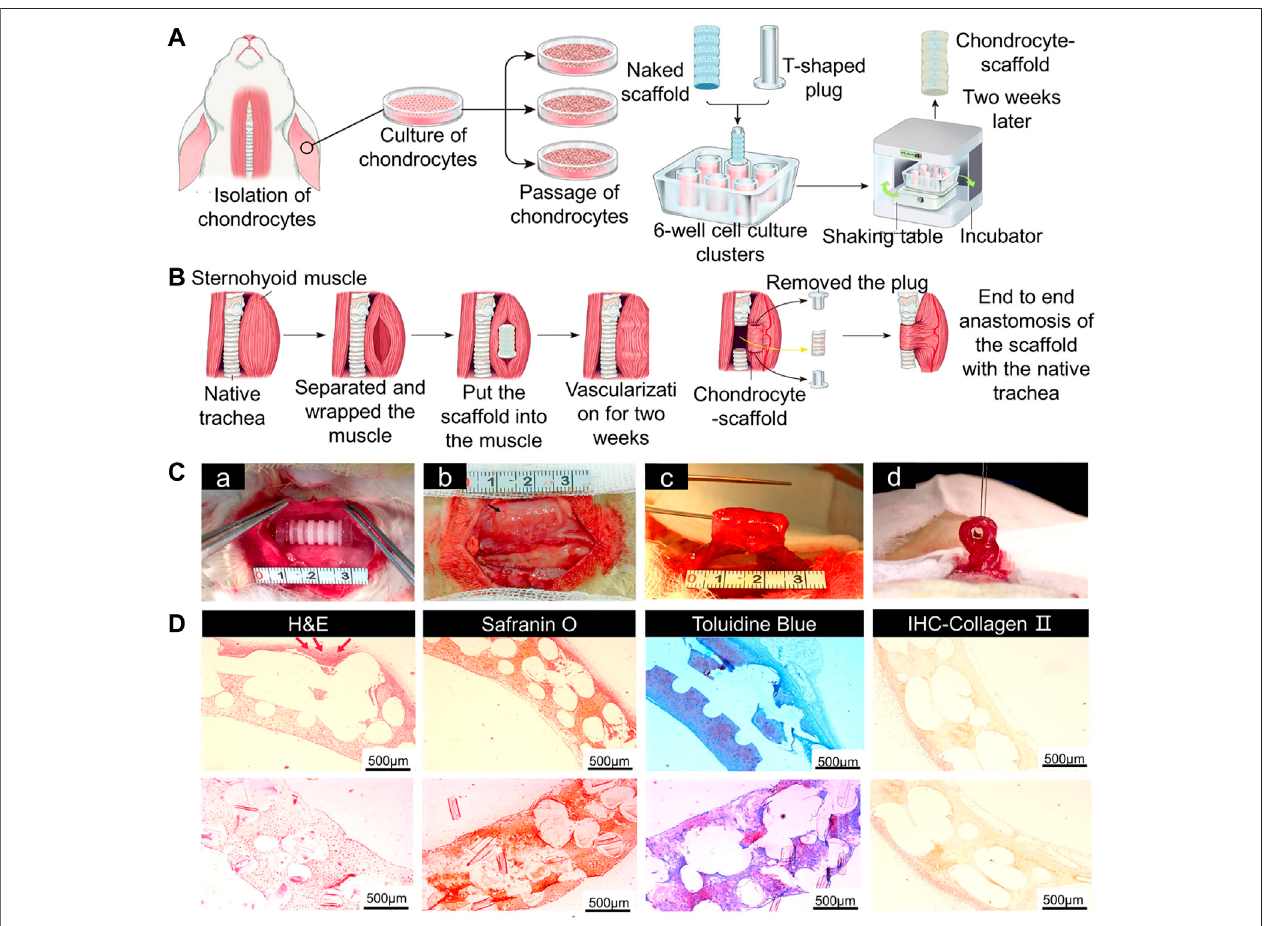
FIGURE 5 | Tracheal cartilage scaffolds were made by 3D printing technology and tested in vivo . (A) Schematic diagram of 3D-printed PLLA tracheal scaffold. (B) Pre-vascularization and tracheal reconstruction of cellular scaffold constructs in vivo . (C) The scaffold was implanted into sternal muscle for pre-vascularization. A completesegmentaltrachealorganunitwithpediclemuscle fl apwasformed. (D) TheimagesofH&E,safraninO,andtoluidinebluestaining,andIHCoftypeIIcollagenof chondrocyte-scaffold constructs. (Scale bar: 500 μ m; red arrow: small blood vessels around the engineered trachea) (Gao et al., 2019).